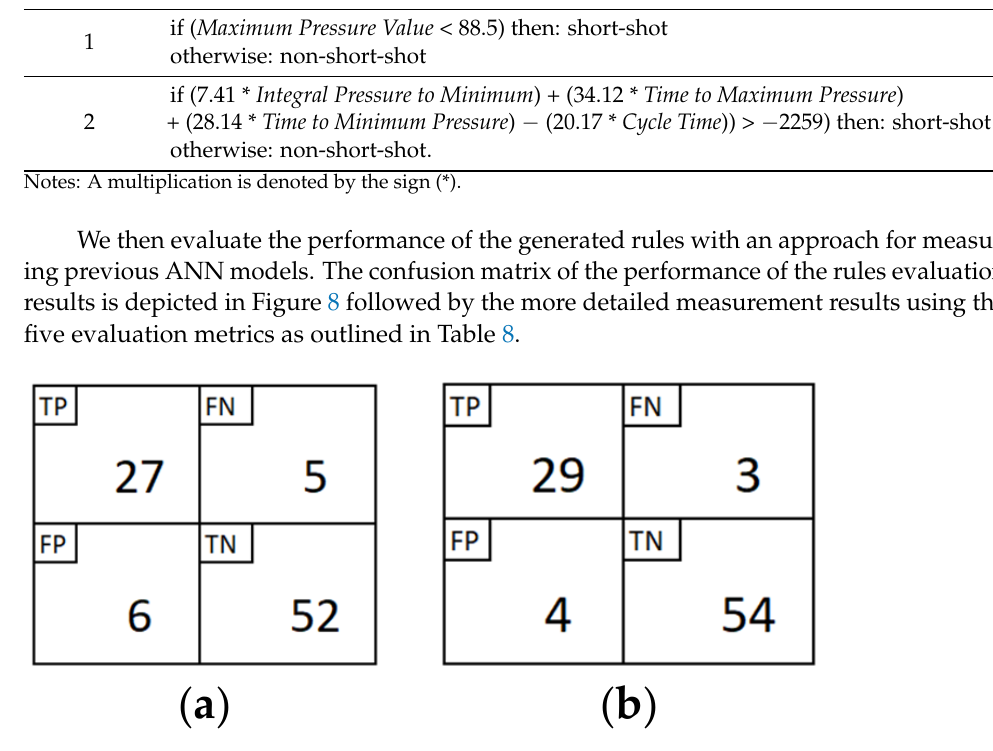
Figure 8. The confusion matrix evaluation of ( a ) rule 1 and ( b ) rule 2. Table 8. Performance evaluation of Rule 1 and Rule 2.